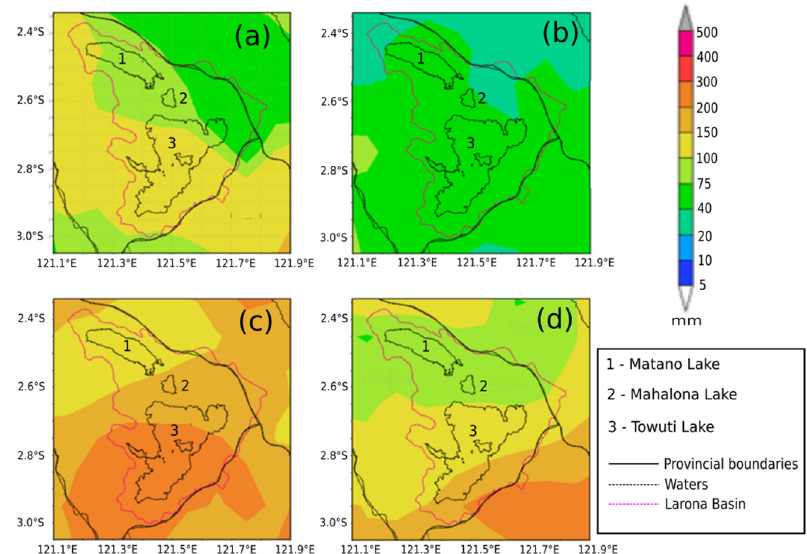
Figure 8. Four periods of total spatial rainfall amount distributions (in mm) from the Larona Basin, Sorowako as obtained from NASA and JAXA’s Tropical Rainfall Measuring Mission (TRMM) satellite: ( a ) the 1st spatial data period was a sum of spatial data from 31 December 2019 to 31 January 2020; ( b ) the 2nd was the sum from 1 to 29 February 2020; ( c ) the 3rd was the sum from 1 to 31 March 2020; ( d ) and the 4th was the sum from 1 to 28 April 2020. The measured total spatial rainfall amount has a spatial resolution of 0.1° and a temporal resolution of 1 h.